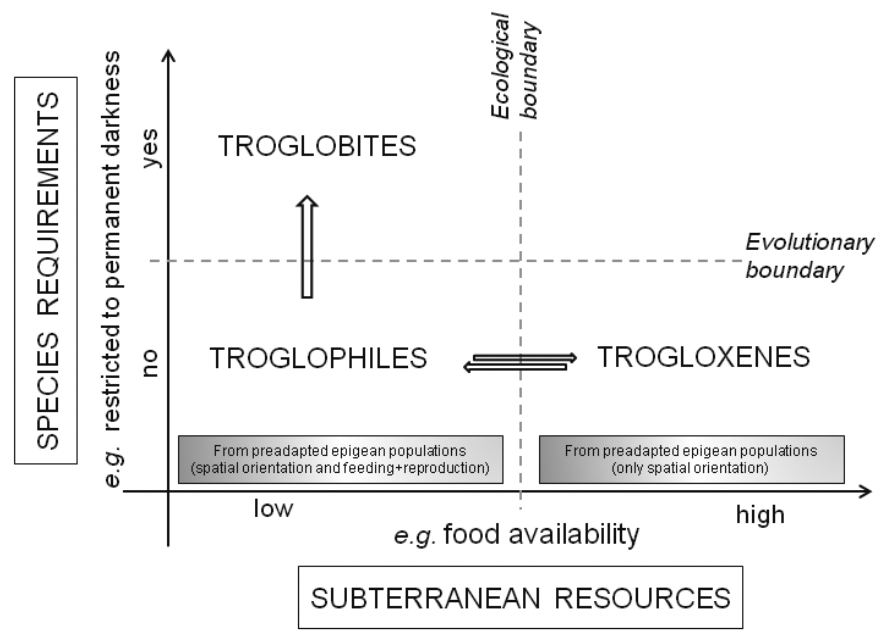
Figure 2. Interrelationships between evolutionary (historical) and ecological (present-day) factors, defin- ing the conditions of trogloxenes versus troglophiles versus troglobites for subterranean